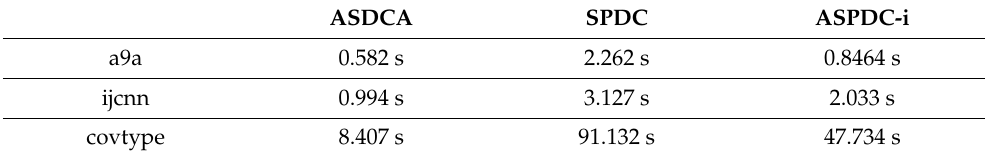
Table 5. The running time for dual-gaps to approach the given precision (10 − 4 ) when λ = 10 − 6 .